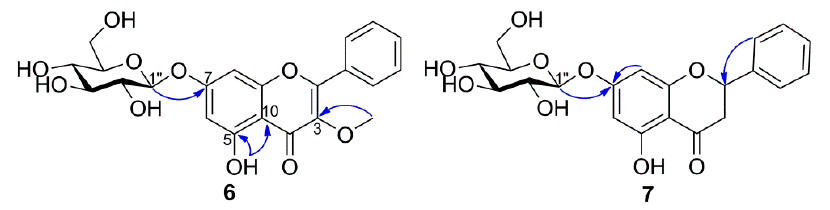
Figure 3. Key HMBC correlations ( 1 H → 13 C) of compounds 6 and 7